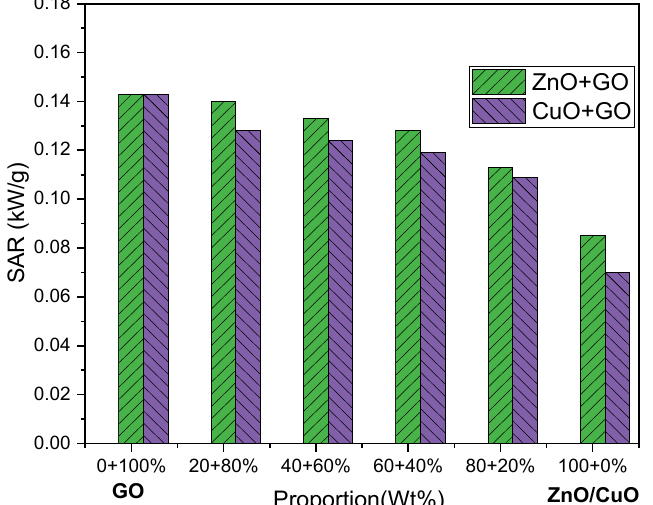
Figure 13. Specific absorption rate (SAR) of CuO, ZnO, and GO nanofluids at three different wt % concentration.